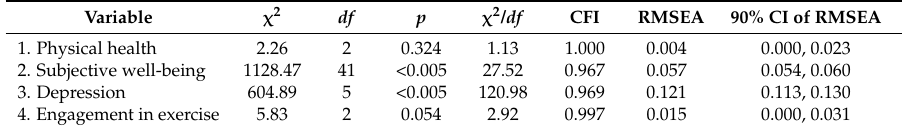
Table 3. Model Fit Indices for Confirmatory Factor Analyses of Latent Constructs of